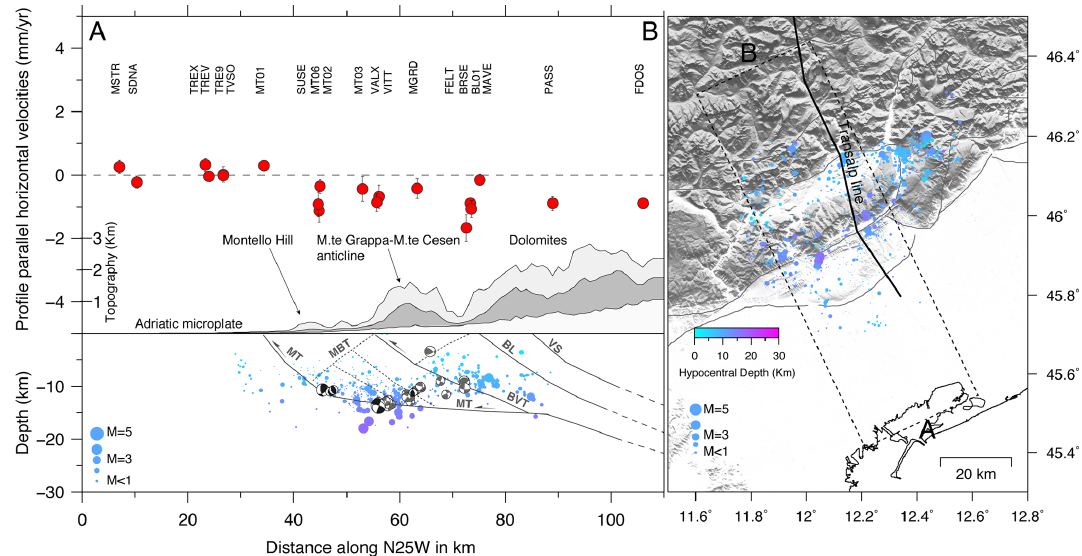
Figure 3. On the left, cross section of GPS velocities, topography, instrumental seismicity and focal mechanisms included in the dashed box of Fig. 2 (and the right panel). Profile-parallel velocity components, in a fixed-Adria reference frame (see Fig. 2), are shown as red circles with 1 σ error bars in gray. The dark gray areas show the average (median) topography in the profile swath, with the light gray and white areas showing the maximum and minimum elevations, respectively. The blue–purple circles show instrumental seismicity in the 2012–2017 time interval, taken from Romano et al. (2019), as a function of depth and scaled with magnitude. The gray and black focal mechanisms are from Anselmi et al. (2011) and Danesi et al. (2015), respectively. The continuous and dashed gray lines represent major and secondary faults digitized from the TRANSALP profile interpretation (modified from Fig. 11 of Castellarin et al., 2006). MT signifies the Montello thrust, MBT signifies the Montello backthrust, BV signifies the Bassano–Valdobbiadene thrust, BL signifies the Belluno thrust, and VS signifies the Valsugana thrust. On the right , map showing the instrumental seismicity recorded by the Collalto seismic network (Priolo et al., 2015) taken from Romano et al. (2019), the swath profile (dashed box), and the TRANSALP line (black